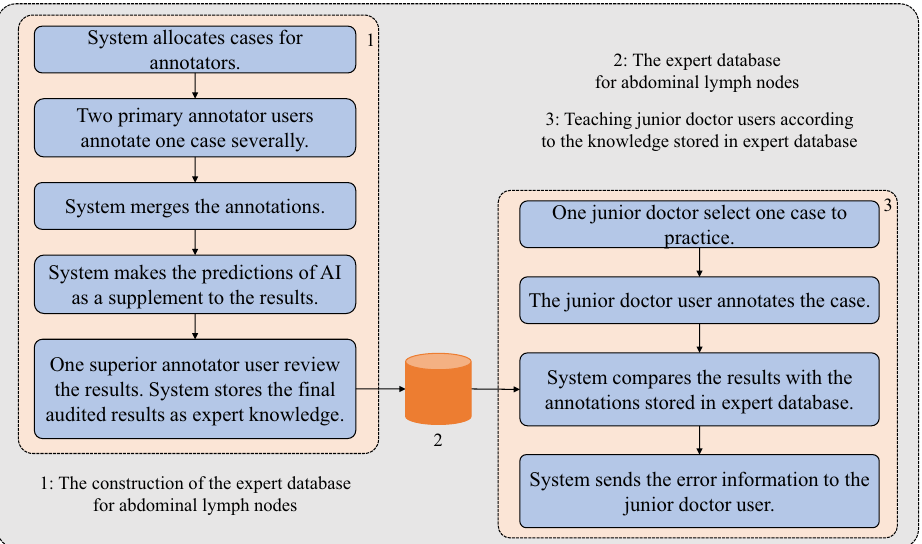
Figure 2. The three functional modules and their workflow of TeachMe. Module 1 is the construction of the expert database for abdominal lymph nodes, which involves the primary annotator users and the superior annotator users. Module 2 is the expert database based on MongoDB. Module 3 is the feedback mechanism, which is the teaching process in TeachMe by comparing the “answers” of junior doctor users with the knowledge in the expert database.